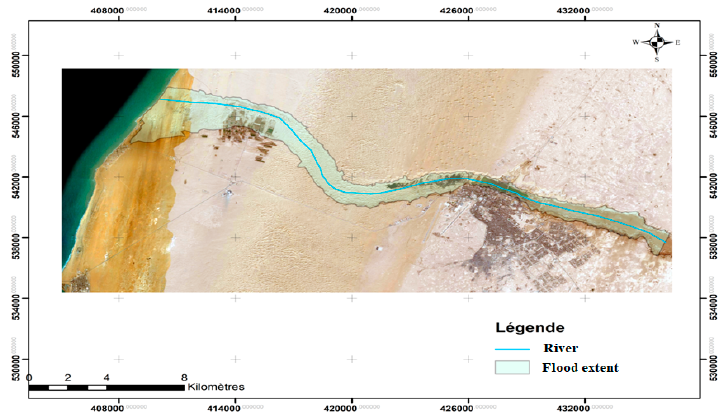
Figure 12. Mapping of the extent of the floodplain for the 2016 flash flood.